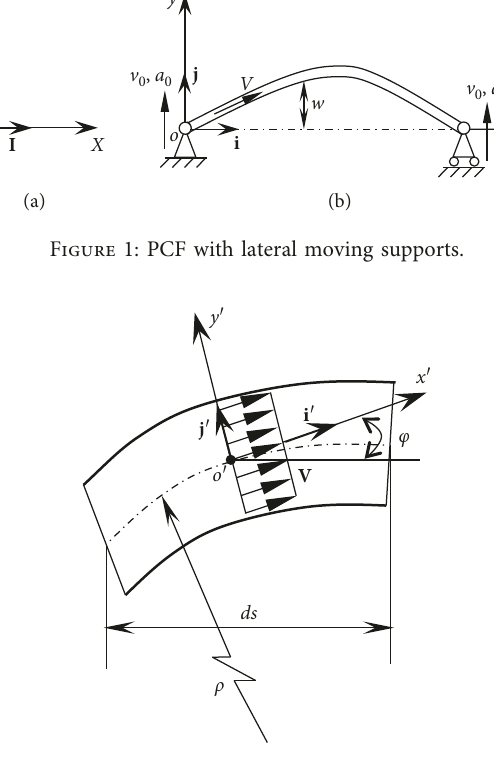
Figure 2: Fluid and pipe